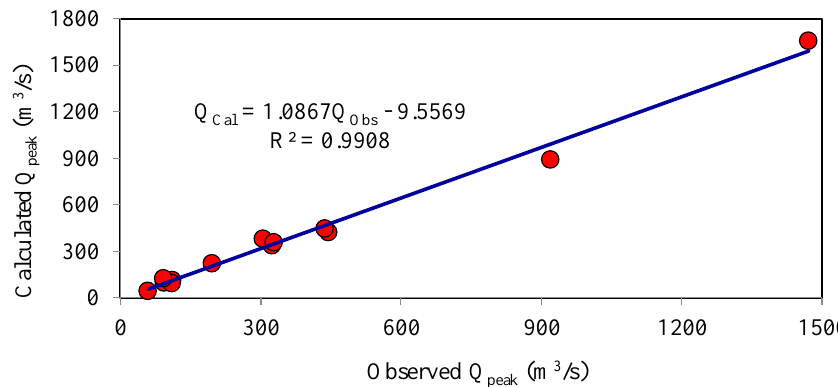
Figure 14. The plot of correlation between peak flows recorded by Bampour gouging station and those calculated by El-Hames formula